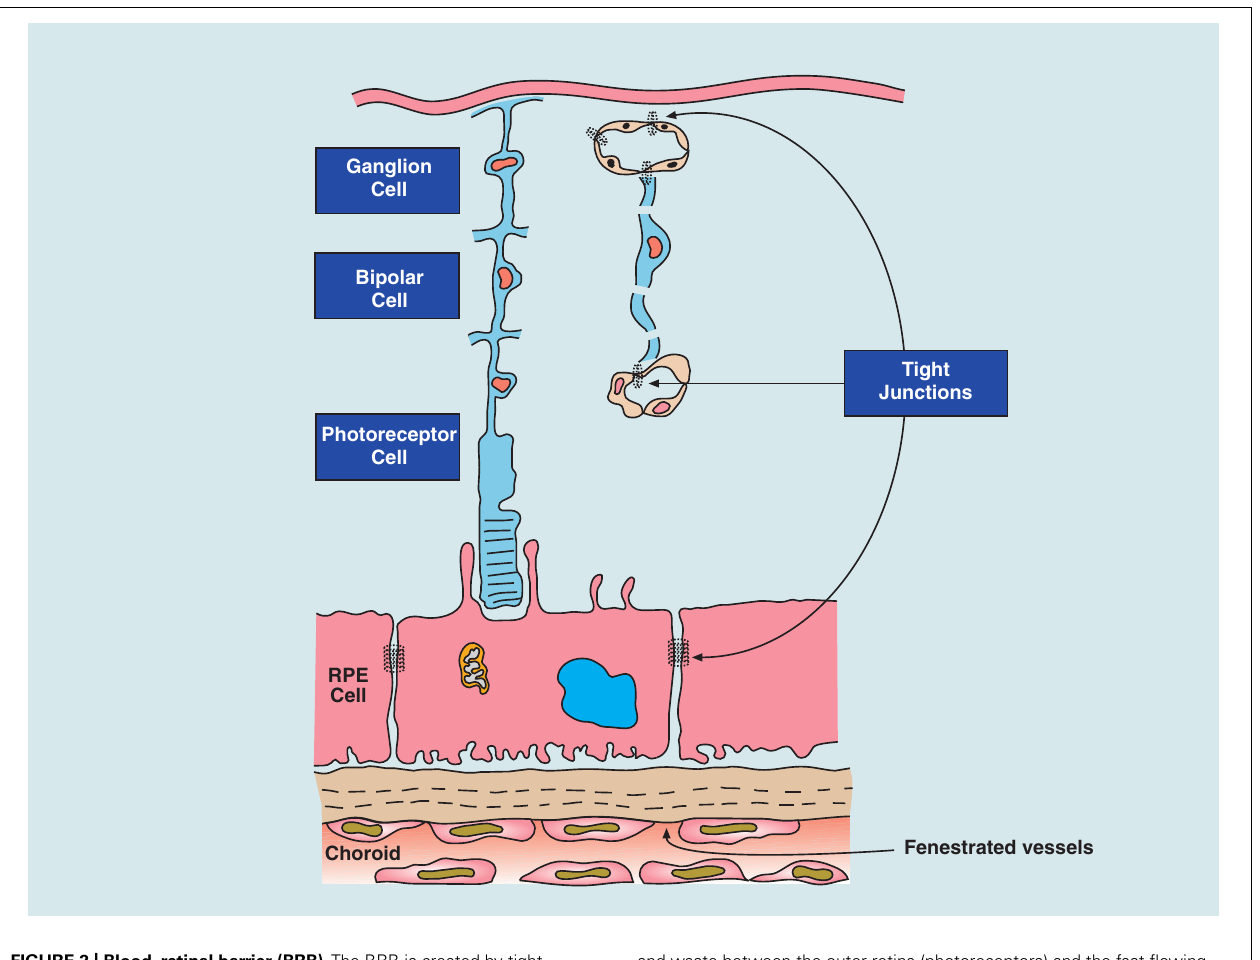
FIGURE 2 | Blood–retinal barrier (BRB). The BRB is created by tight junctions at two sites: between endothelial cells of the retinal vessels that supply the inner retina (ganglion cells and bipolar cells) and the retinal pigment epithelium (RPE cell; which filters blood from the fenestrated, leaky choroidal vessels).The RPE regulates two-way transport of fluid, nutrients,